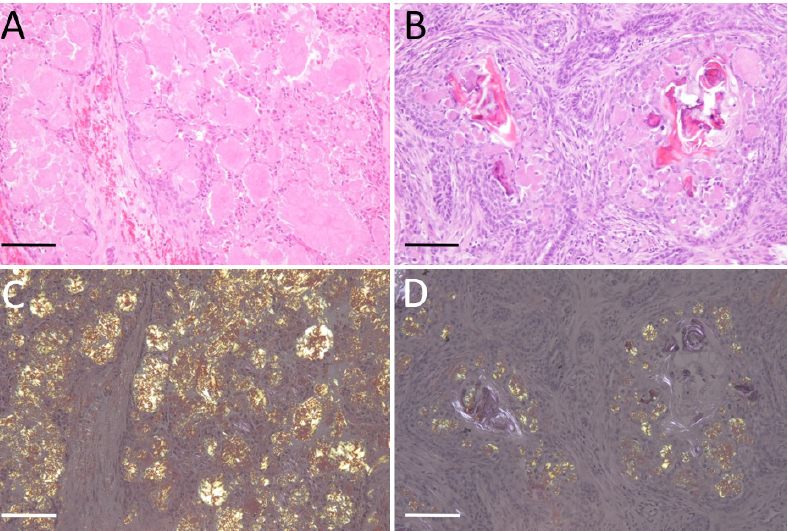
Figure 1. Amyloid-producing ameloblastoma (APAB); ( A ) APAB; dog No. 3. Cystic proliferation of odontogenic epithelium and amyloid deposits in island and stroma. H&E stain. ( B ) APAB; cat No. 2. Left maxillary mass, severe amyloid deposits in interstitium and tumor epithelial cells. H&E stain. ( C ) APAB; dog No. 3. Amyloid deposits show yellow-green birefringence under polarized light. Congo red stain. ( D ) APAB; cat No. 2. Congo red stain. Scale bars: 200 µ